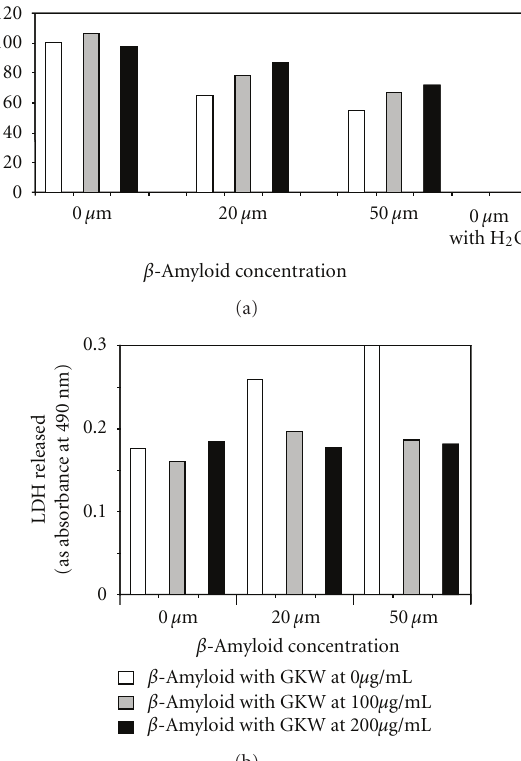
Figure 4: (a) GKW at 100 and 200 μ g/mL shows a modest protective e ff ect on SH-SY5Y cells from A β toxicity (beta amyloid 25–35) in vitro . The % of live cells is decreased on treatment with A β , an e ff ect which is attenuated by GKW. Hydrogen peroxide 500 μ M is used as a 0 cell viability control. (b) GKW at 100 and 200 μ g/mL protects SH-SY5Y cells from A β toxicity (beta amyloid 25–35) in vitro — LDH release. The amount of LDH (lactate dehydrogenase) released is increased on treatment with A β , an e ff ect which is attenuated by GKW. LDH release is a marker of cell